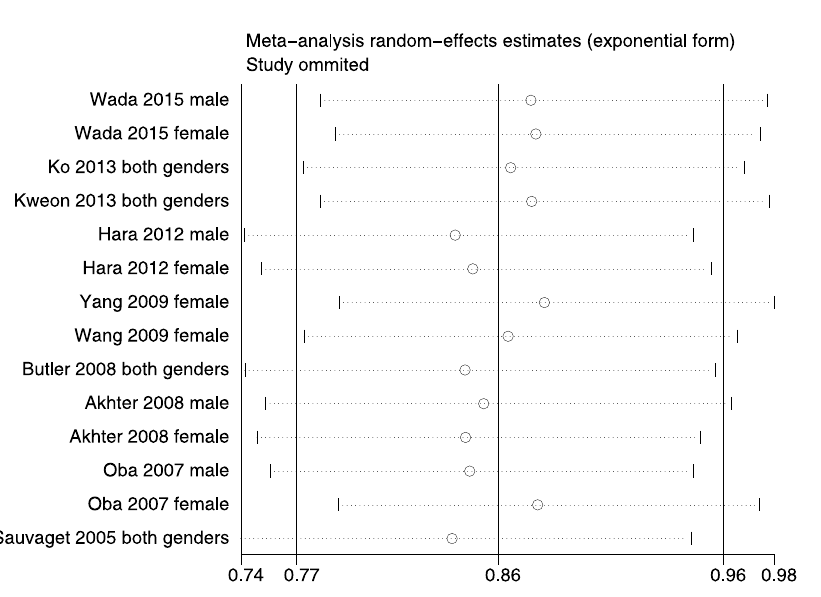
Figure 3. Forest plot and summary risk estimates for females of the association between soy product intake and incidence of GI cancer.